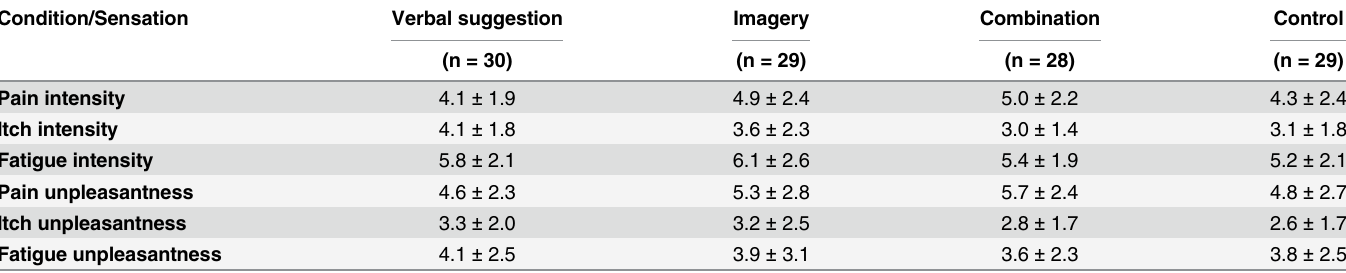
Table 1. Means and standard deviations of NRS intensity and unpleasantness scores of pain, itch, and fatigue during the respective tests.